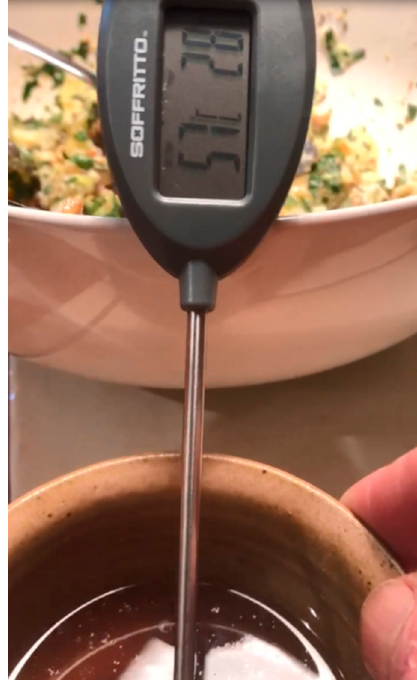
Figure 3. Tattykeel Australian White intramuscular fat (liquid at room temperature) indicating a low fat melting point (FMP).